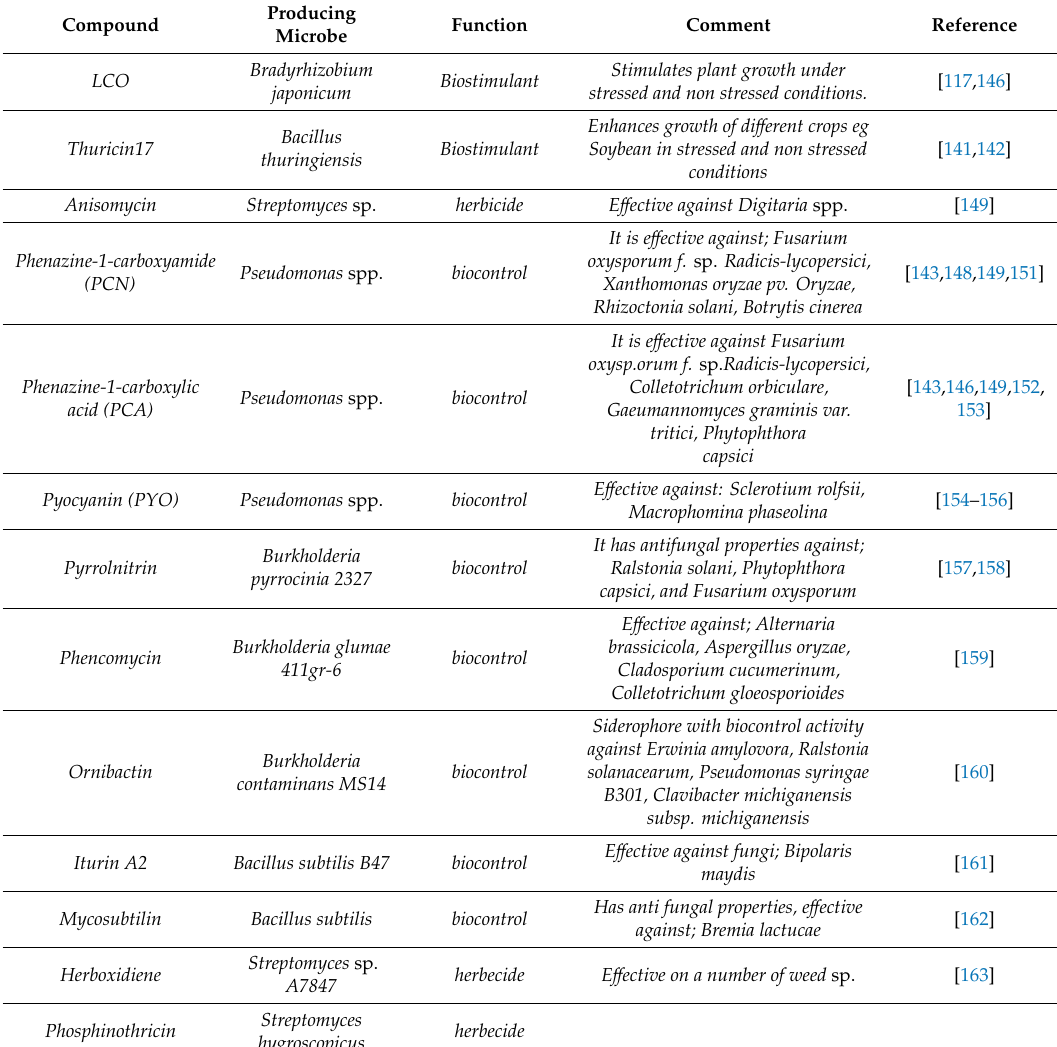
Table 4. Microbial compounds of agricultural